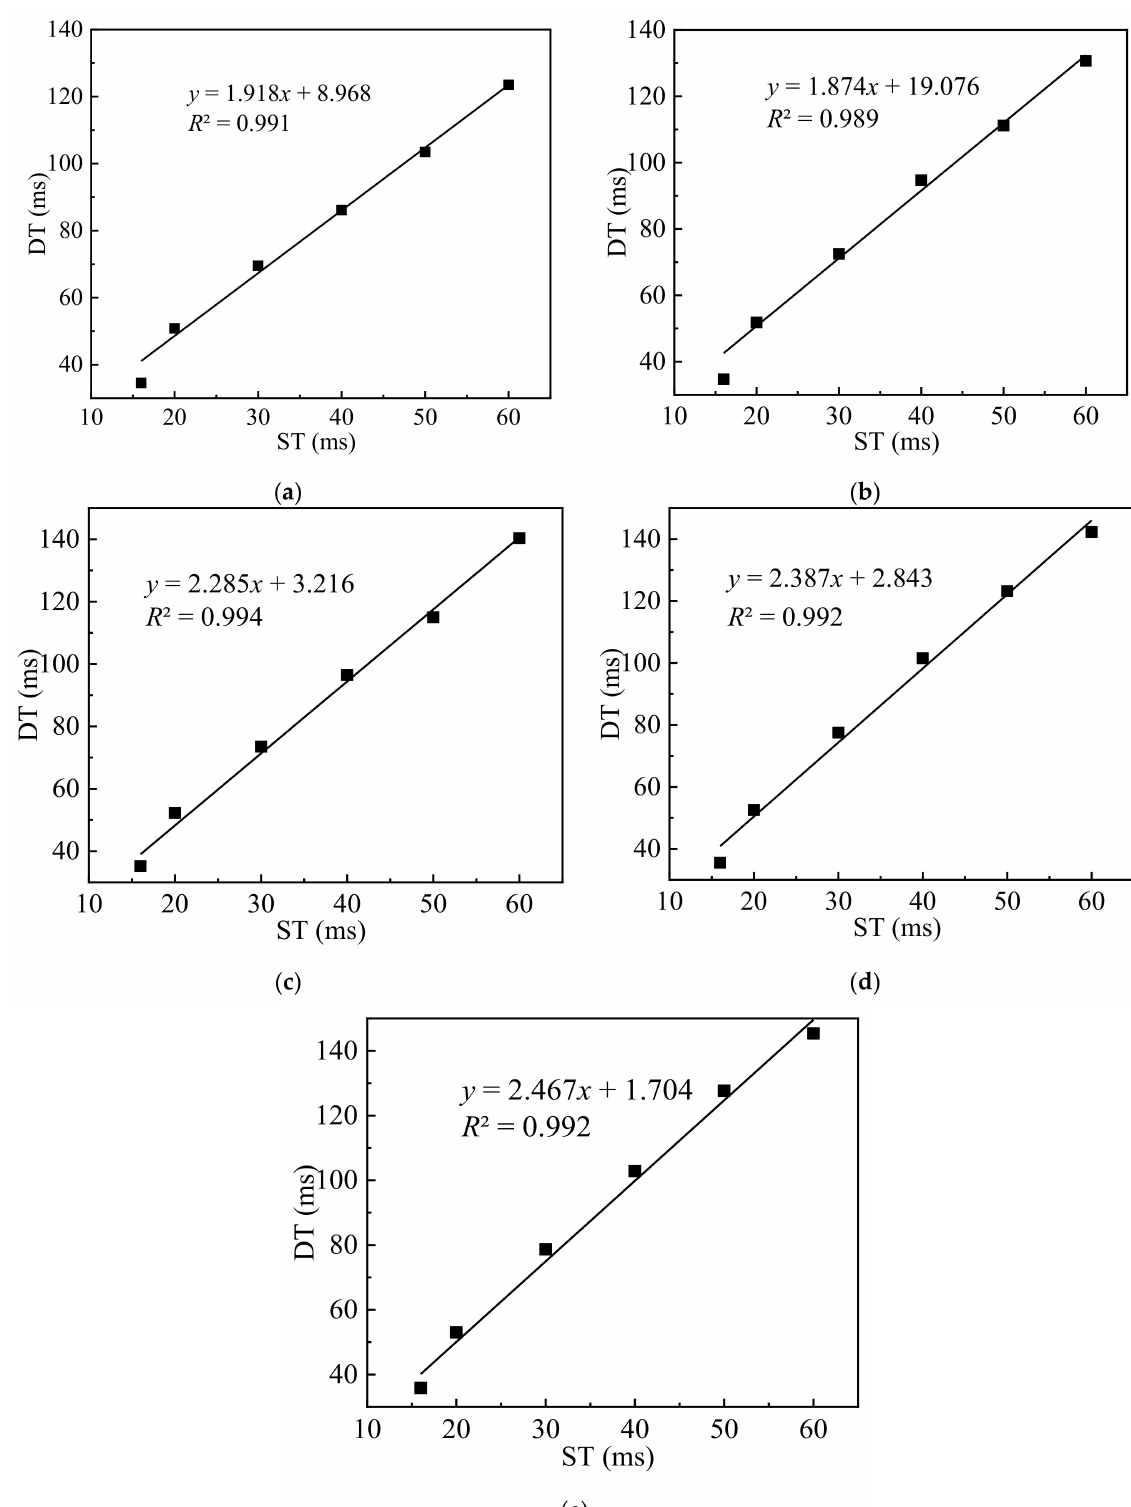
Figure 9. Relationship of the duration of the application of the liquid starter fertilizer to every seed (DT) and the time set using the timer in the controller (ST) at different pressures of ( a ) 0.10, ( b ) 0.15, ( c ) 0.20, ( d ) 0.25 and ( e ) 0.30